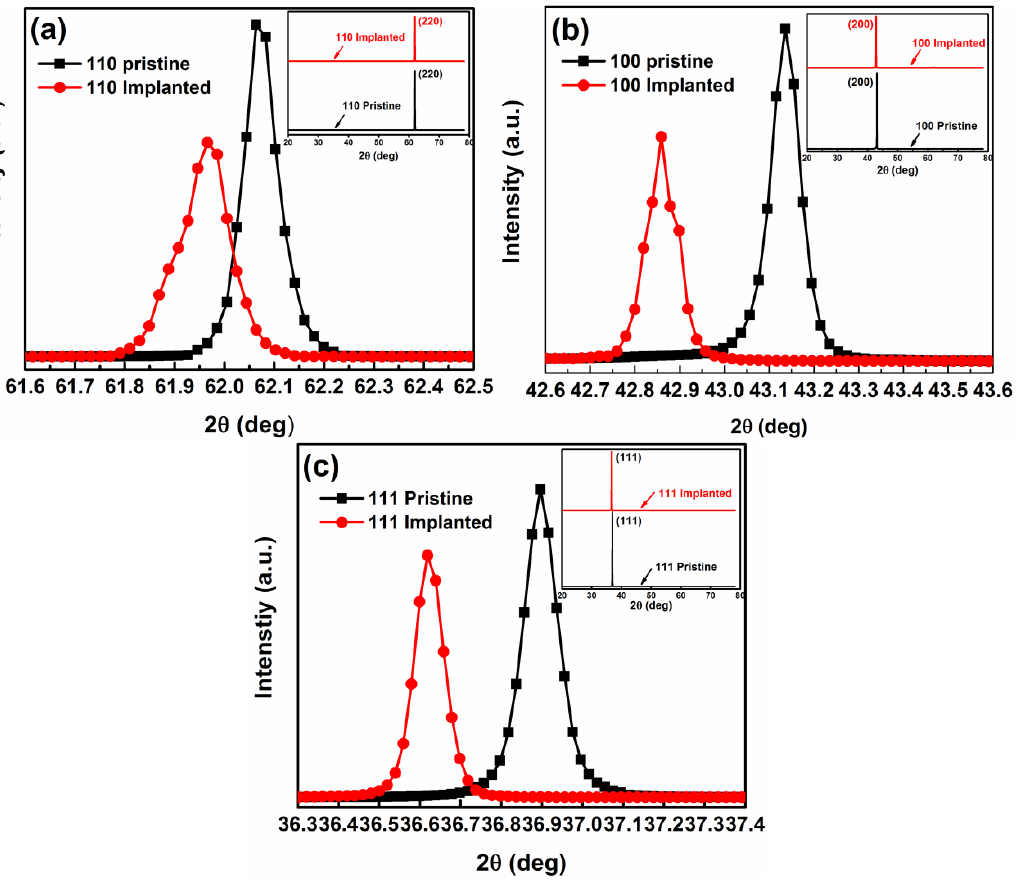
Figure 4. HRXRD patterns of for pristine and implanted MgO samples with ( a ) (110) orientation, ( b ) (100) orientation, and ( c ) (111) orientation.